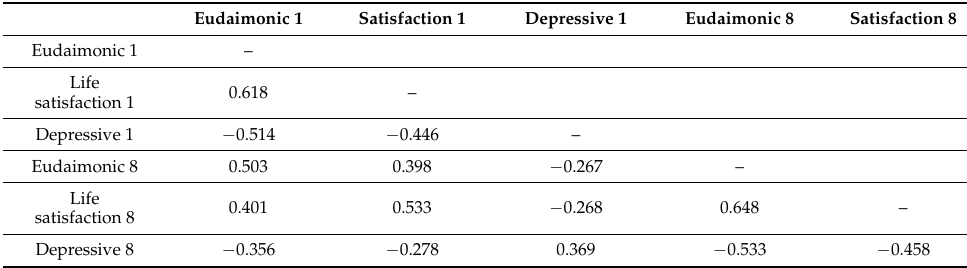
Table 3. Correlation Matrix for Main Variables for Time Points 1 and